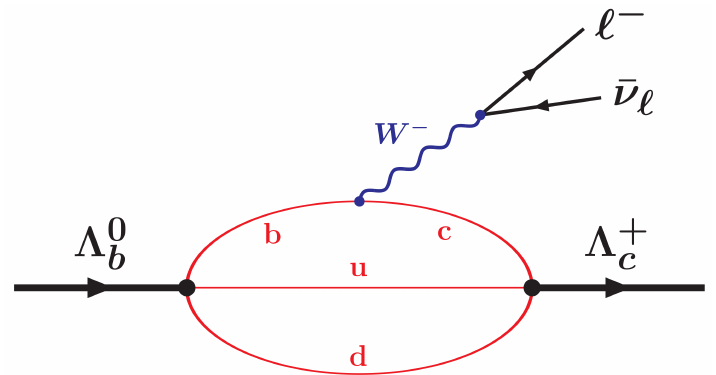
Figure 2. Feynman diagram describing the semileptonic decay Λ 0